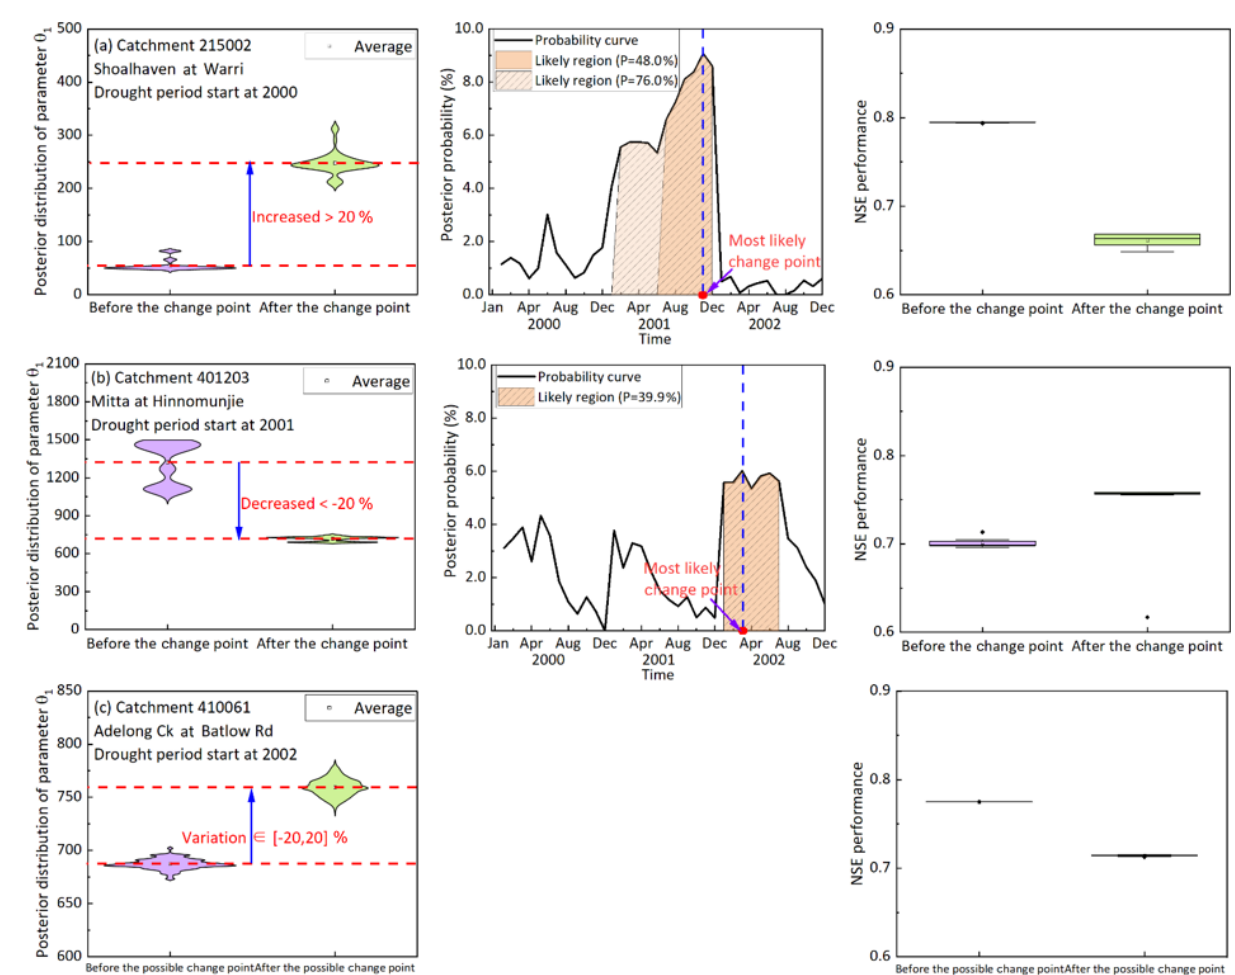
Figure 3. Examples of shifts in model parameter θ 1 : (a) catchment 215002 with a significant upward change in θ 1 , (b) catchment 401203 with a significant downward change in θ 1 and (c) catchment 410061 with a nonsignificant change in θ 1 . The first column compares the posterior distributions of θ 1 calibrated during the periods before and after the change point. The second column denotes the posterior probabilities based on all possible change points. The last column denotes the Nash–Sutcliffe efficiency (NSE) performance of the model parameters calibrated during the periods before and after the most likely change